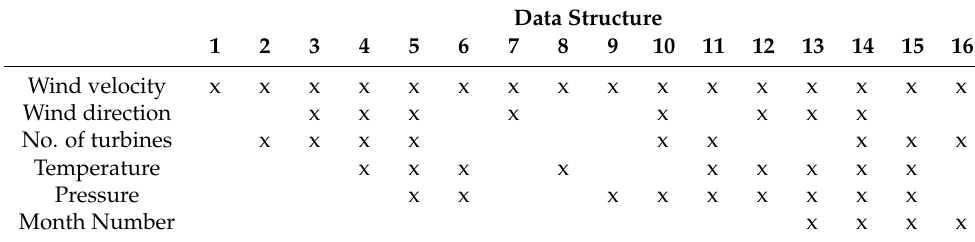
Table 4. Analyzed input data structures, wind power plant.